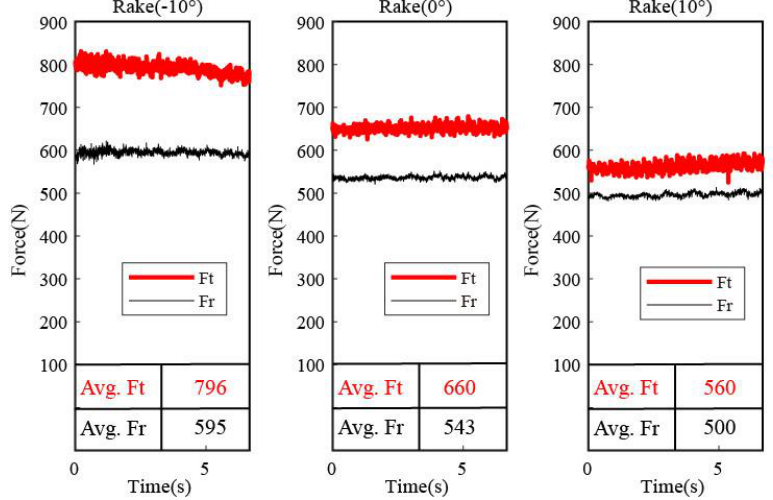
Figure 5. Monitored cutting force and comparison between inserts with different rake angles.